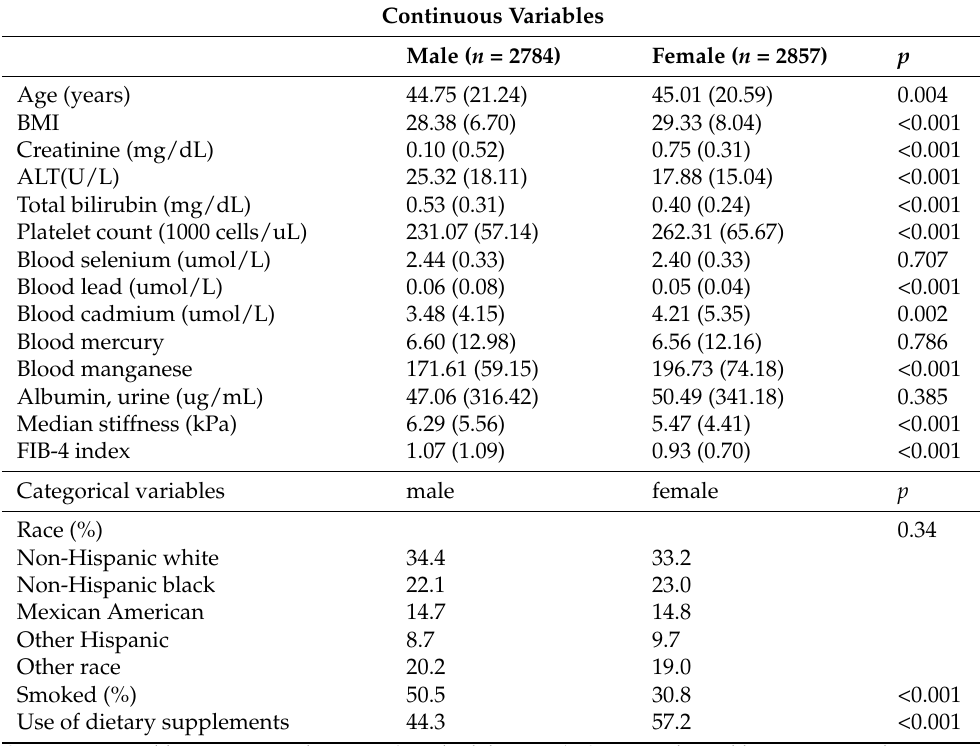
Table 1. Characteristics of study participants.